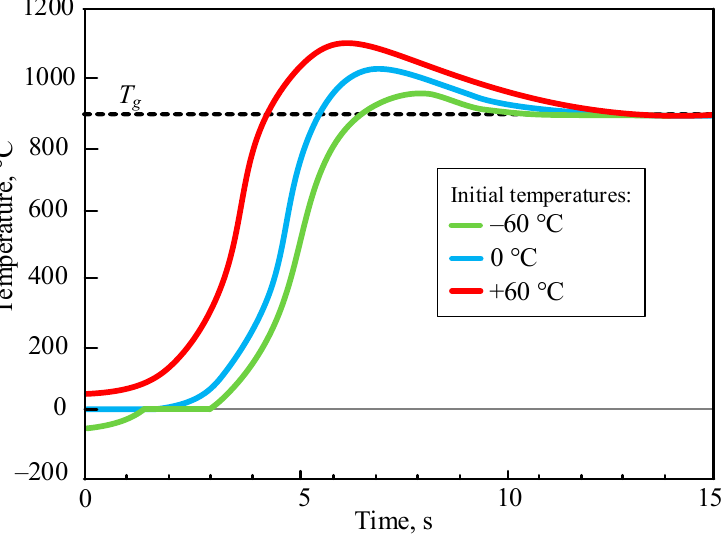
Figure 4. Typical temperature trend in the droplet of composite fuel during heating based on [33].